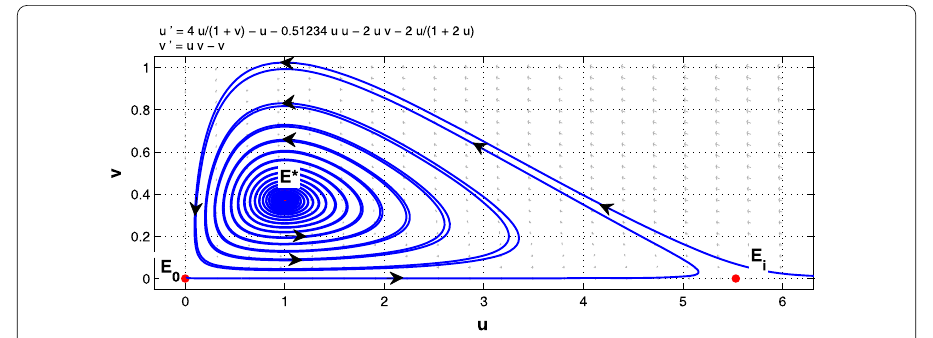
Figure 1 Dynamic behavior of system (1.1) with r 0 = 4, k = 1, d = 1, a = 0.51234, p = 2, E = 1, m 1 = 1, m 2 = 2, c = 0.5, q = 2 < 2.30553 = q H , E ∗ is stable